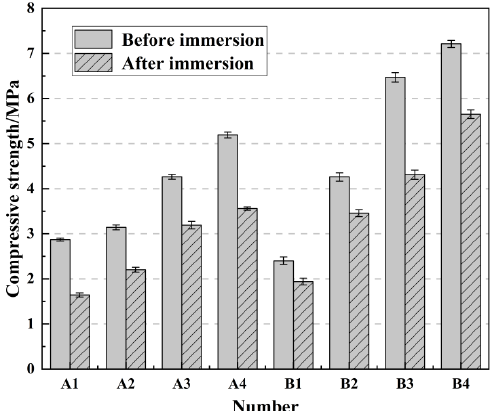
Figure 6. Change of compressive strength in 7 days curing age immersion curing.